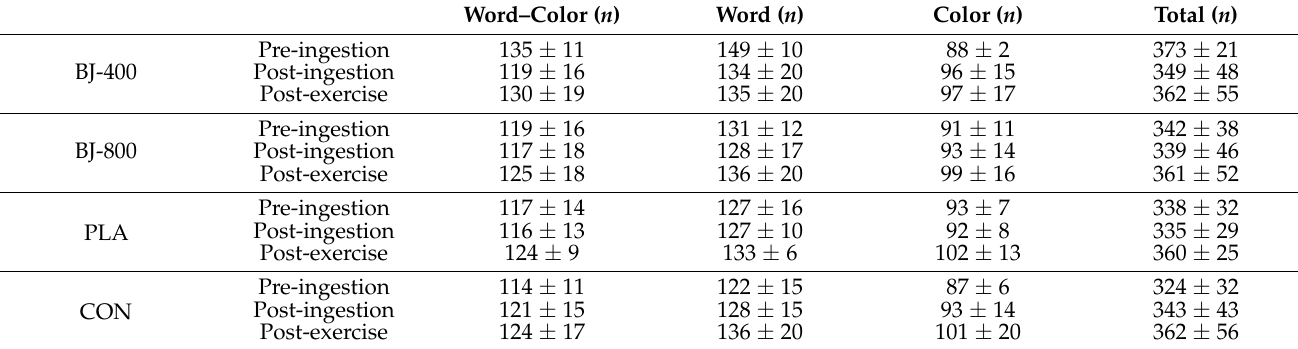
Table 2. Stroop test performance in the different experimental